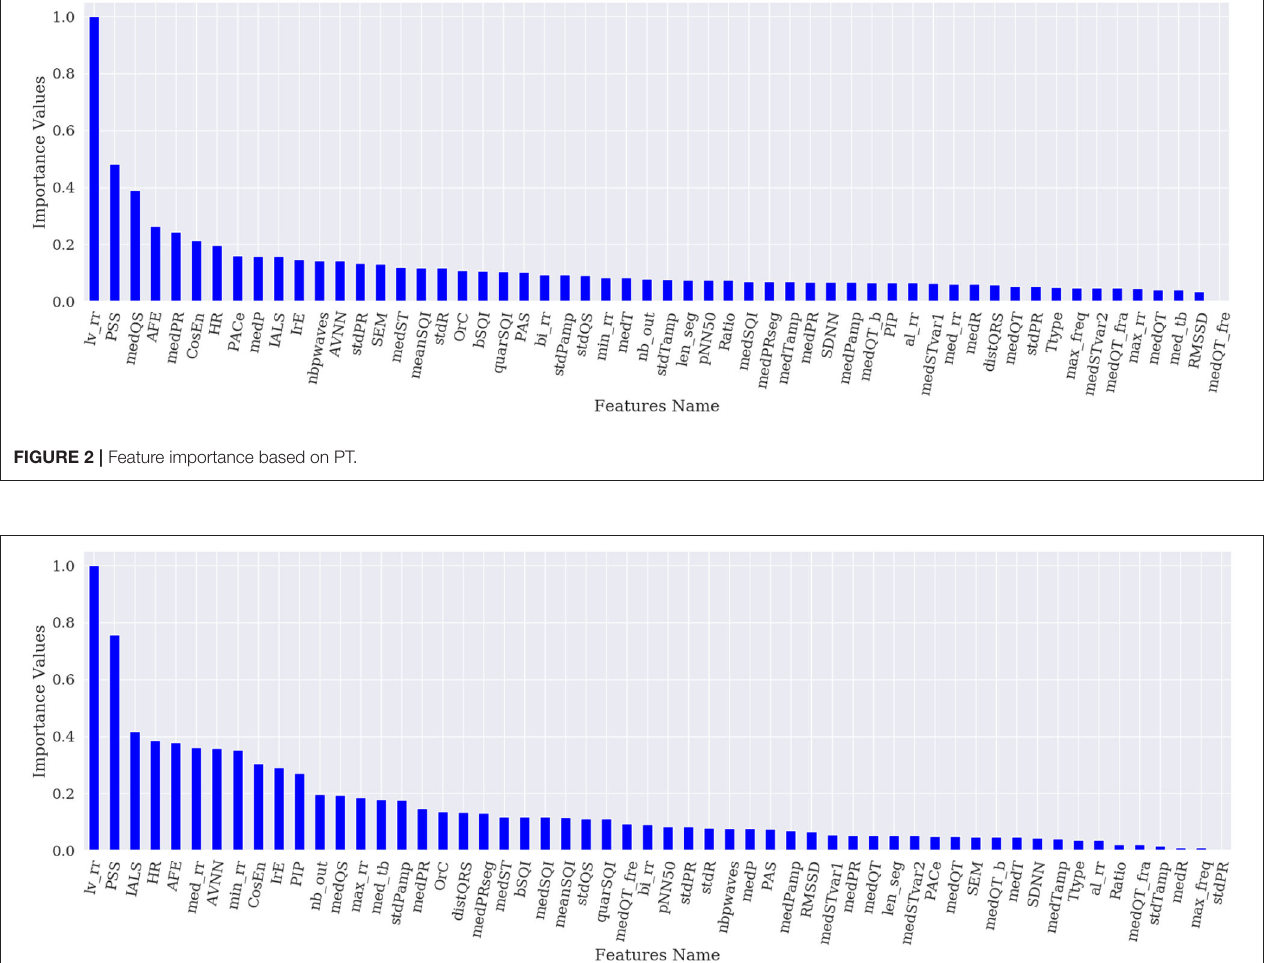
FIGURE 3 | Feature importance based on RF.